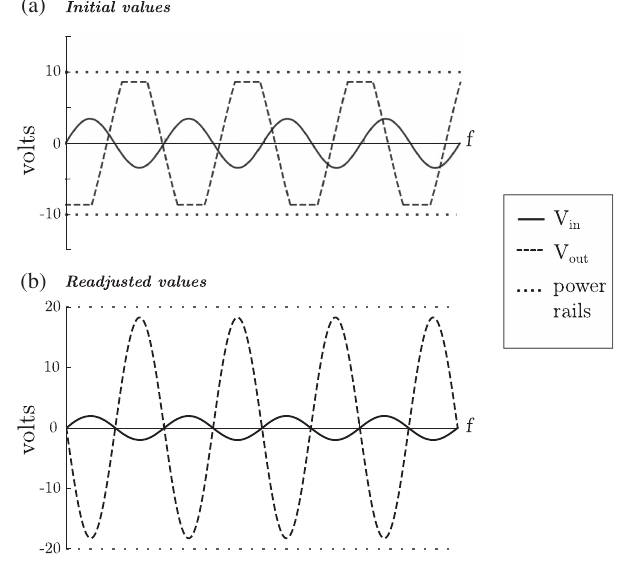
FIG. 3. A simulated plot of the input (solid line) and output (dashed line) voltage signals on an oscilloscope with given power rails (dotted line). (a) With the initial conditions, the output signal will appear clipped due to the power rail limit. The slight slant of the output signal is due to slew-rate limits. (b) After hypotheti- cally increasing the power rails and decreasing V and the slight distortion due to the slew rate limit is